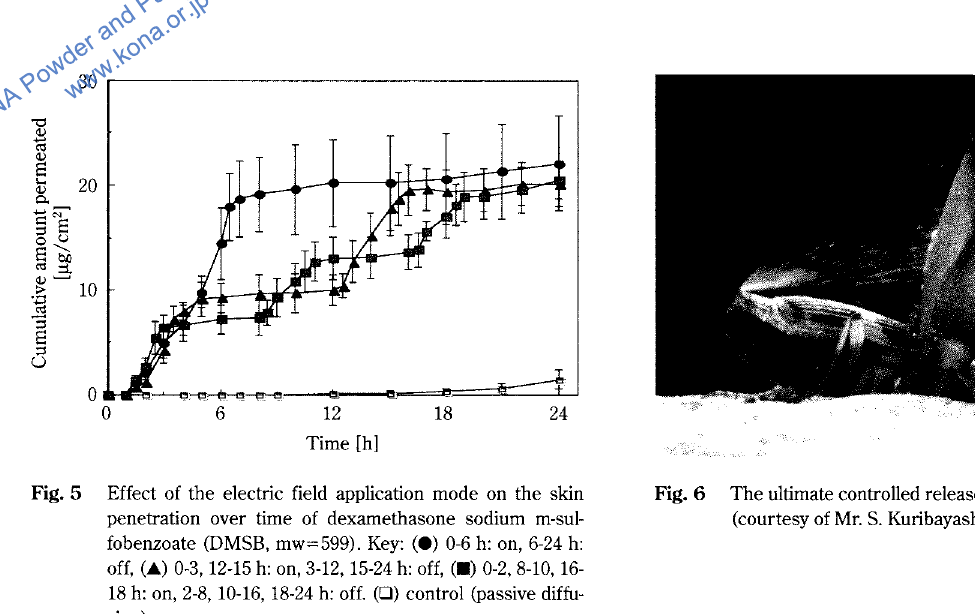
Effect of the electric field application mode on the skin penetration over time of dexamethasone sodium m-sul fobenzoate (DMSB, mw=599). Key: (e) 0-6 h: on, 6-24 h: off, (4) 0-3, 12-15 h: on, 3-12, 15-24 h: off, (•) 0-2, 8-10, 16- 18 h: on, 2-8, 10-16, 18-24 h: off. (0) control (passive diffu sion)